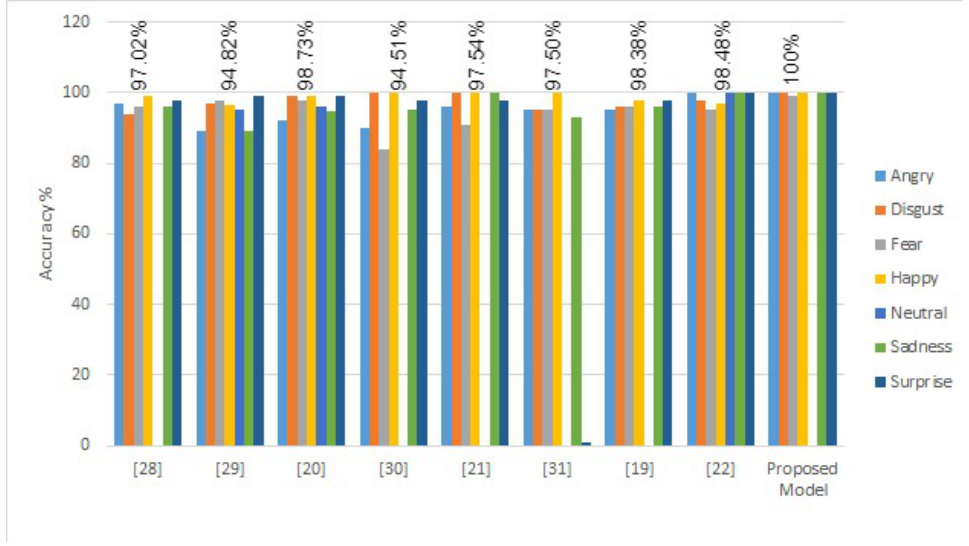
Figure 16. Class accuracy of the model compared with other